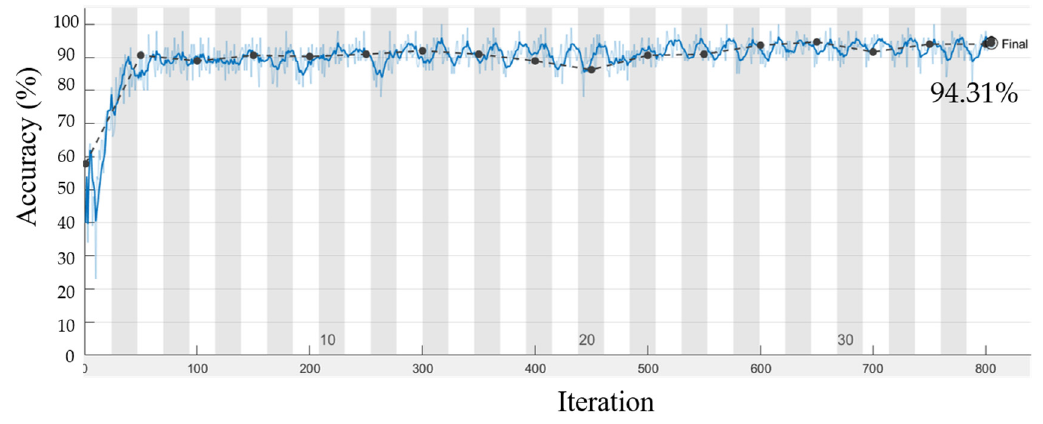
Figure 14. The learning curve of deep learning for three types of minerals. (The horizontal axis shows the iteration and the vertical axis shows the accuracy of classification. The blue line shows the accuracy for the learning data set and the black dots represent the accuracy for the verification data set.).